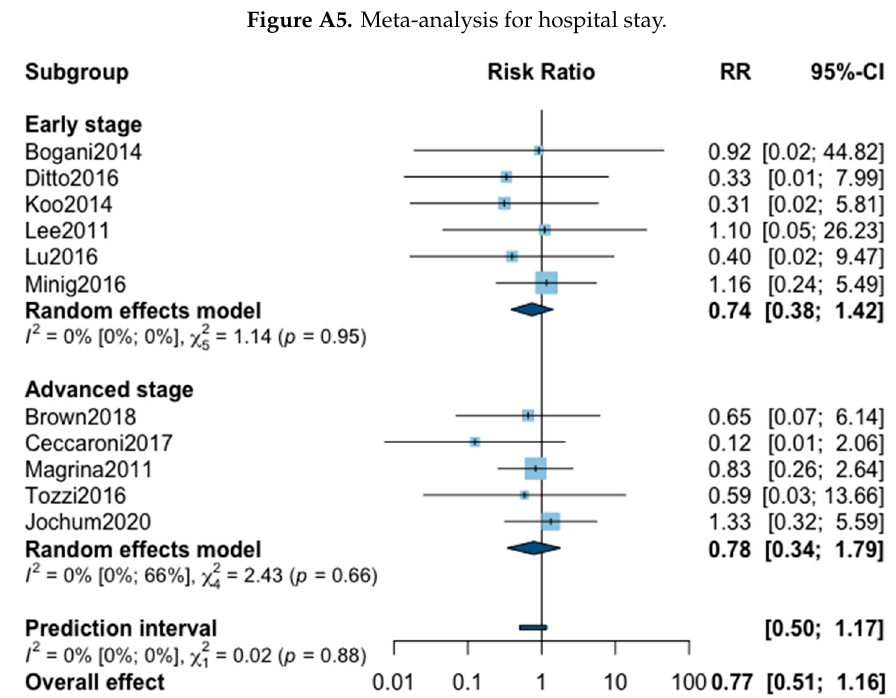
Figure A6. Meta-analysis for intraoperative Figure A6. Meta ‐ analysis for intraoperative complications . Figure A6. Meta ‐ analysis for intraoperative complications .